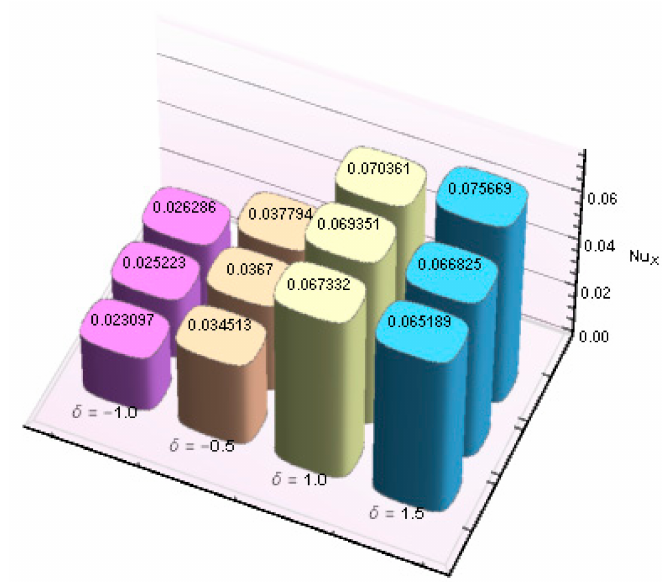
Figure 14. Variation in Nu x against δ .